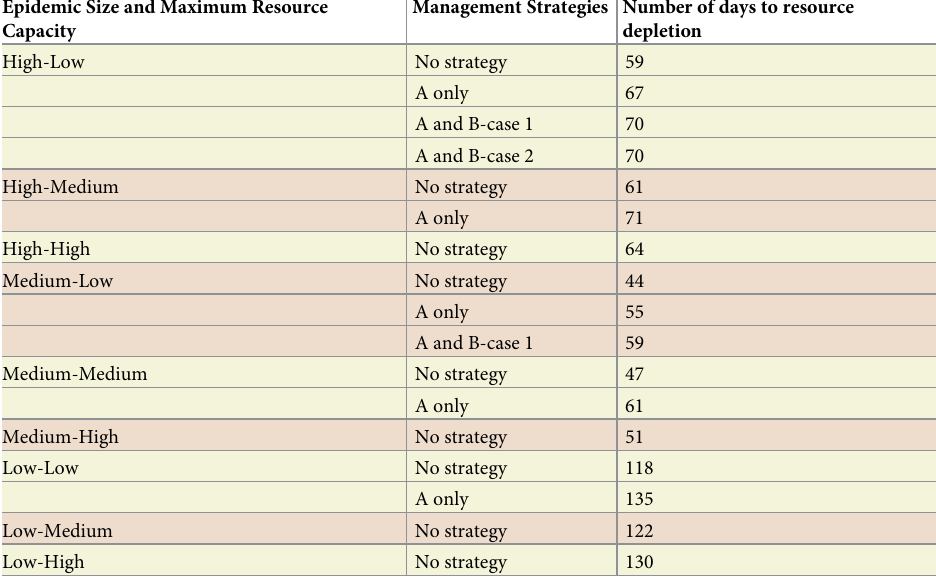
Table 5. Scenario analysis results for the number of days to resource